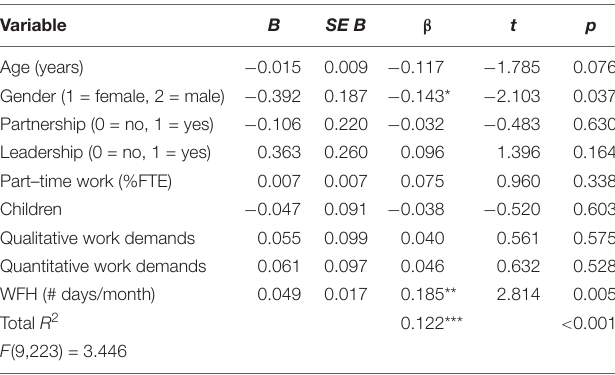
TABLE 3 | Multiple linear regression analysis for work from home (WFH) predicting less distractibility in WFH compared to work on-site (H2).